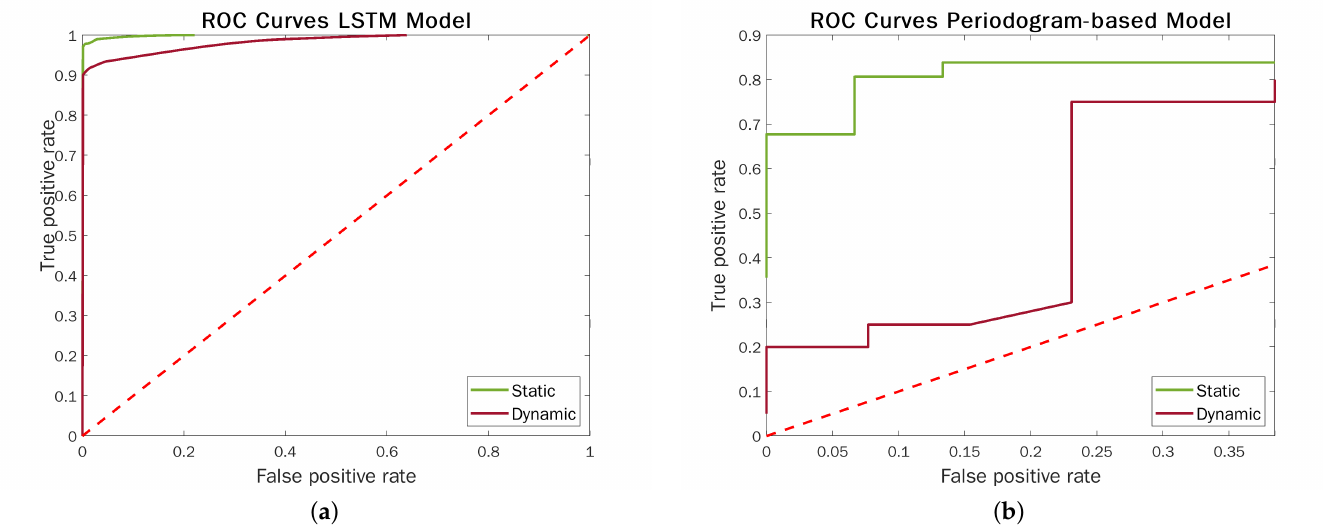
Figure 12. ROC curves LSTM vs. Periodogram-based TLC models in static and dynamic settings. The red dashed line indicates a random classifier. ( a ) ROC Curves LSTM model—raw data. Discriminating threshold = probability predicted by the model for the gold class. ( b ) ROC Curves Periodogram-based model—raw data. Discriminating threshold = minimum amplitude in the vertical FFT spectrum for human detection ( amp th